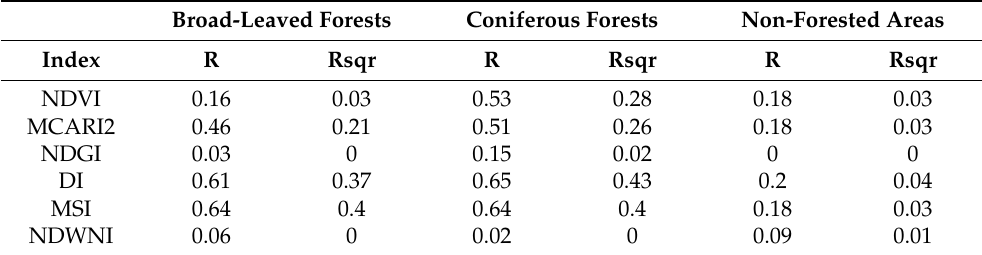
Table 5. Linear regression between forest density (independent) and spectral indices (dependent) for each of the forest